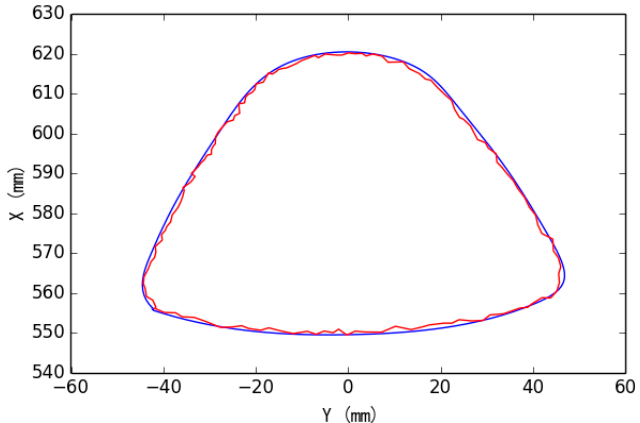
second layered deburring; ( c ) third layered deburring.